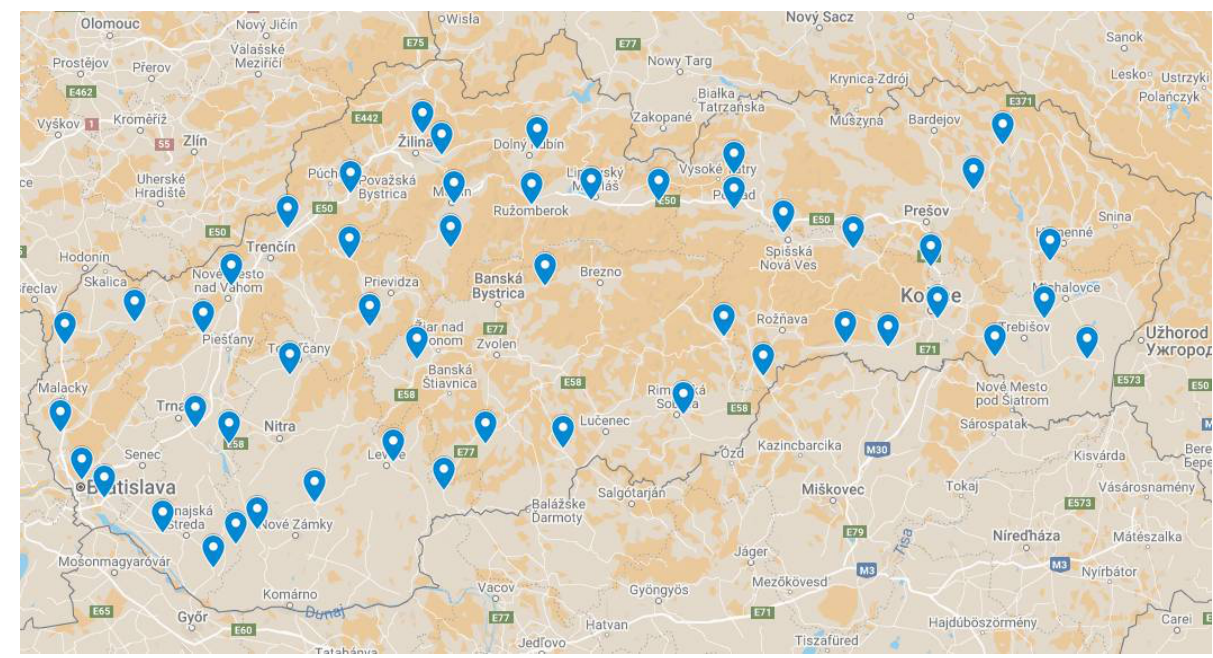
Figure 1. Locations of field measurements in our 2020–2021 campaign around Slovakia.